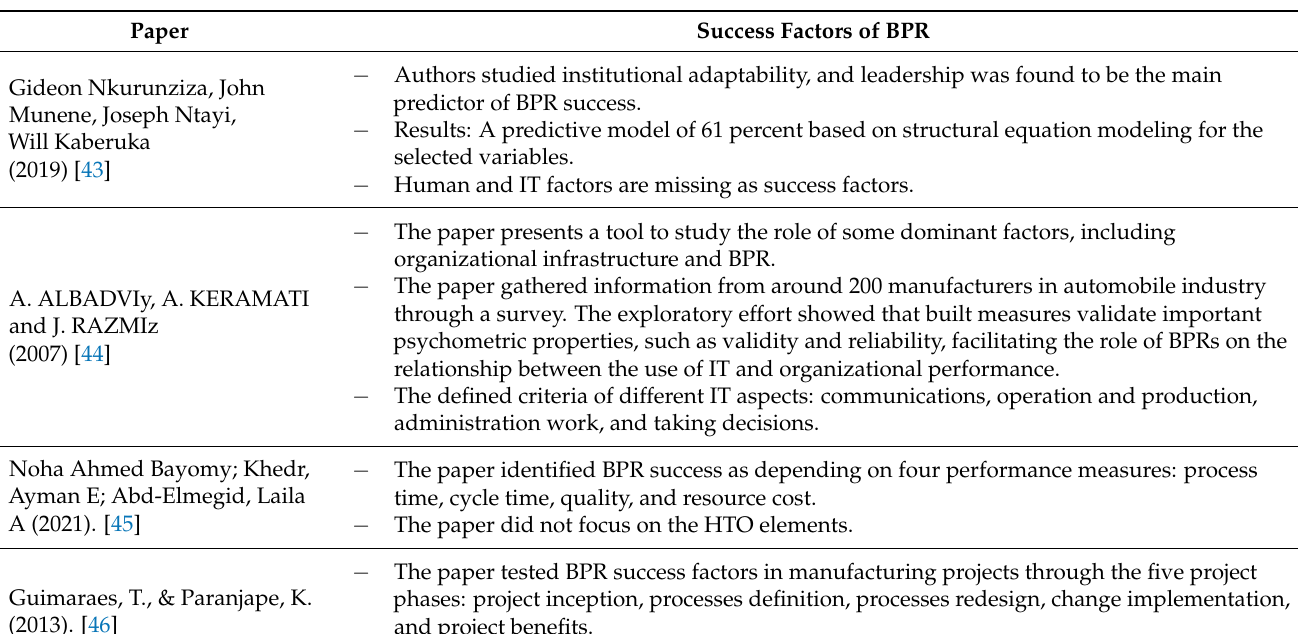
Table 1. BPR success factors in additional literature based on HTO